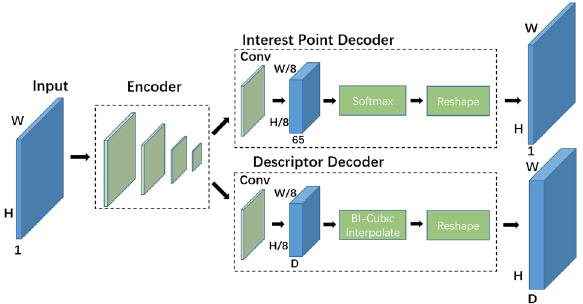
Figure 2. SuperPoint Network Architecture. The feature detector